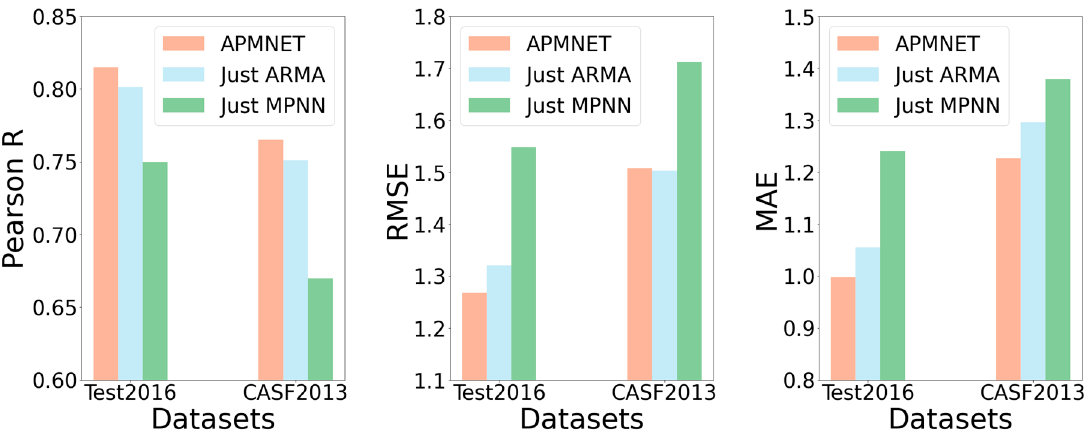
Figure 5. Performance with Pearson R, RMSE, and MAE for different ablation test model.